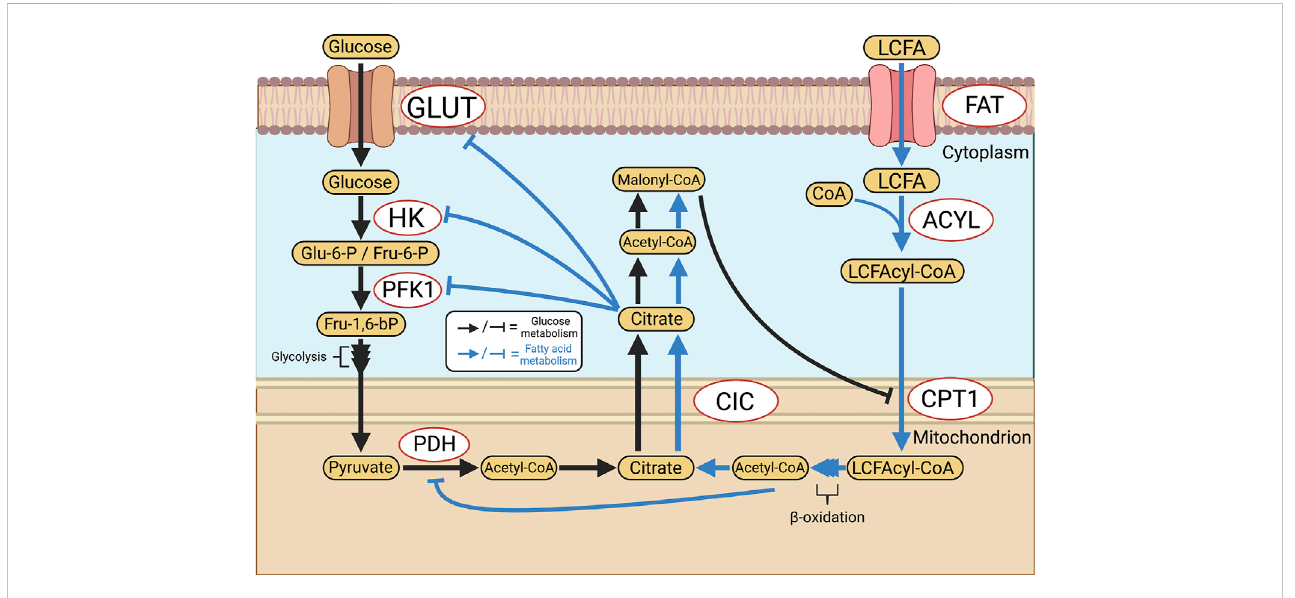
FIGURE 5 Reciprocal inhibition of glucose and fatty acid oxidation: the Randle Cycle. The Randle cycle refers to the phenomenon that products of GO inhibit FAO and vice versa . FAO is inhibited by GO at the level of CPT1 and the import of long-chain fatty acids into mitochondria, thereby increasing levels of free fatty acids. In the cytosol GO is inhibited by citrate, which reduces cytoplasmic glycolysis, whilst in the mitochondria PDH is inhibited by FAO-derived, mitochondrial, acetyl-CoA. Abbreviations: ACYL — Long chain fatty acyl-CoA ligase; CIC — Citrate carrier; CPT1 — Carnitine palmitoyltransferase 1; FAT — Fatty acid translocase; GLUT — Glucose transporter; HK — Hexokinase; LCFA — Long-chain fatty acid; PDH — Pyruvate dehydrogenase; PFK1 — Phosphofructokinase 1; TTP — Tricarboxylate transport